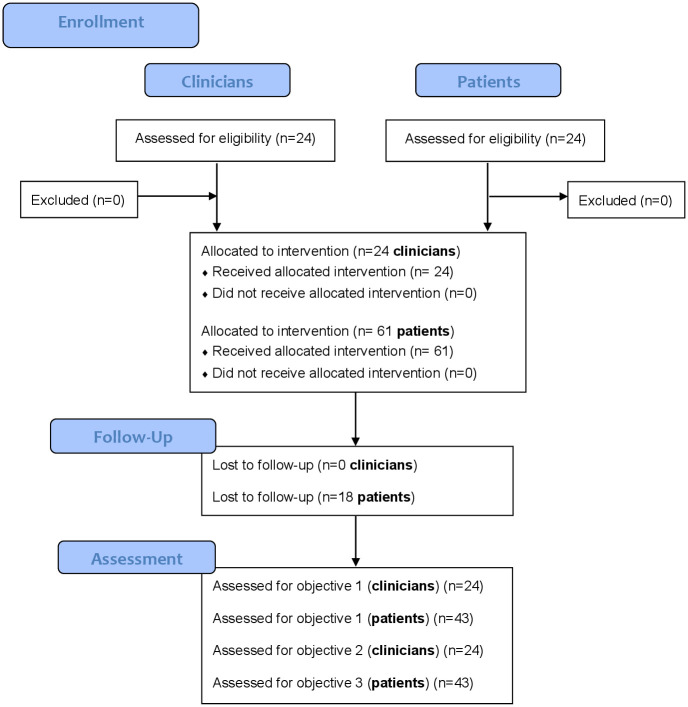
Study flowchart.